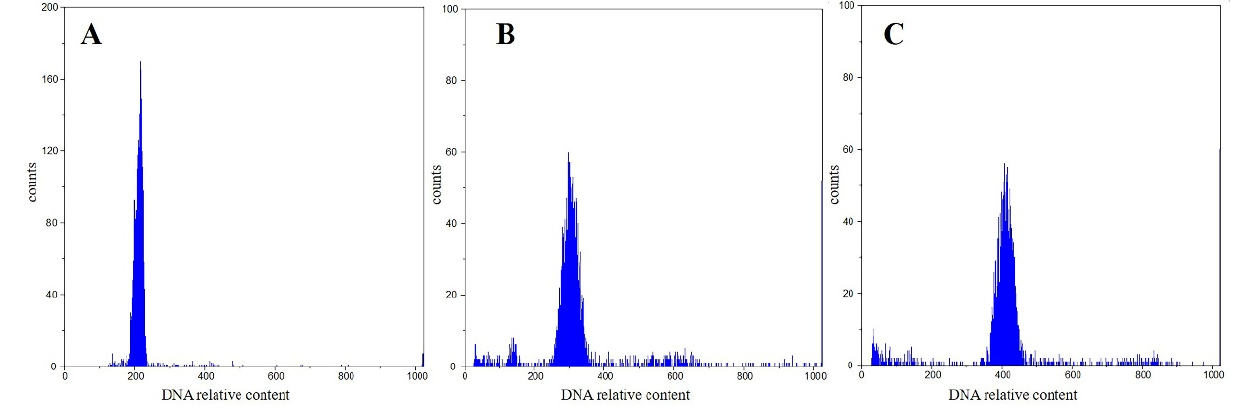
Figure 1. Peak values of relative DNA content. ( A ): diploid loach; ( B ): hybrid triploid loach; ( C ): tetraploid loach.